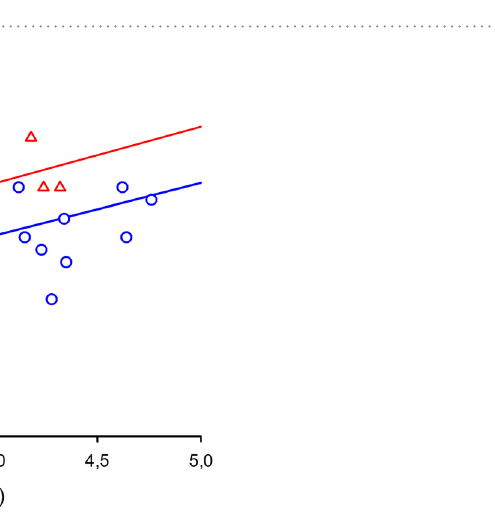
Table 1. Statistical results of a General Linear Mixed Model (GLMM) with heart rate as dependant variable, treatment (yolk-removed versus control eggs) as fixed factor, clutch of origin as random factor, and egg mass as continuous predictor.